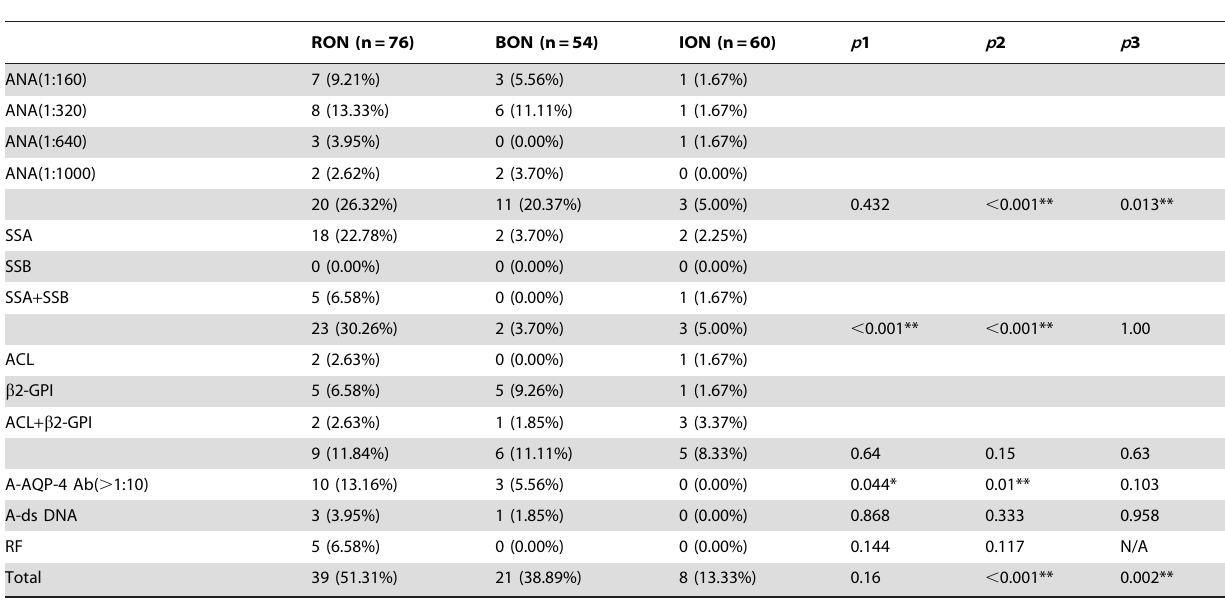
Table 2. Detection of autoantibodies in patients with ON.